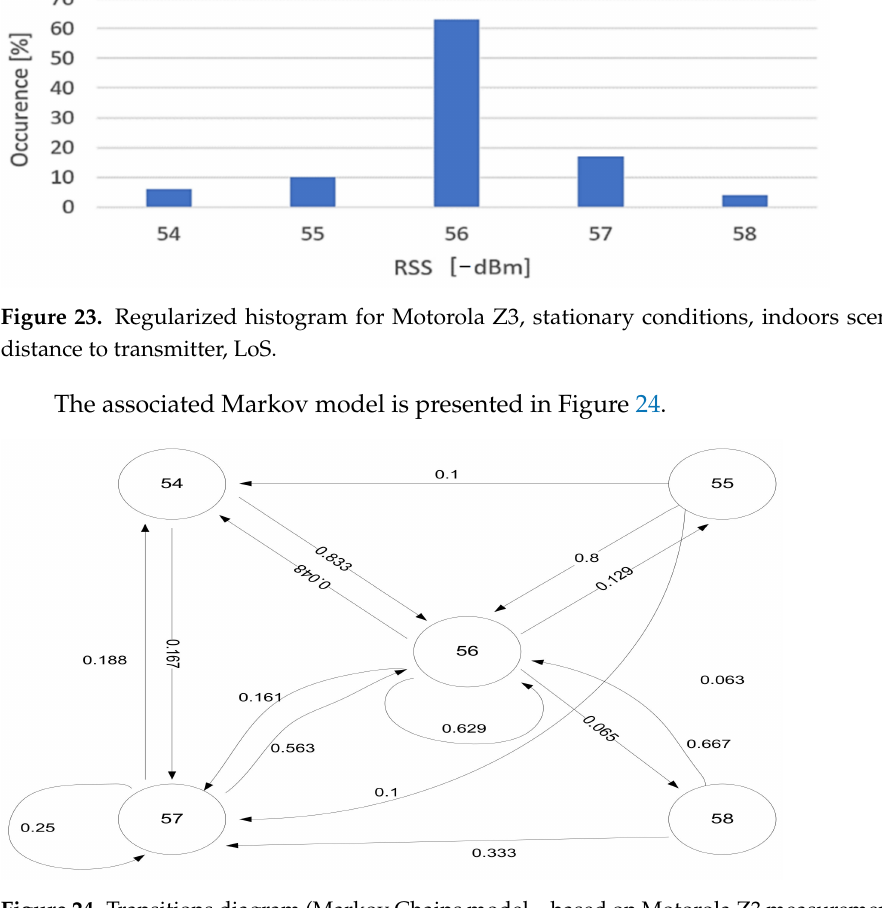
Figure 24. Transitions diagram (Markov Chains model—based on Motorola Z3 measurements, indoor conditions, LoS, 1 m distance to